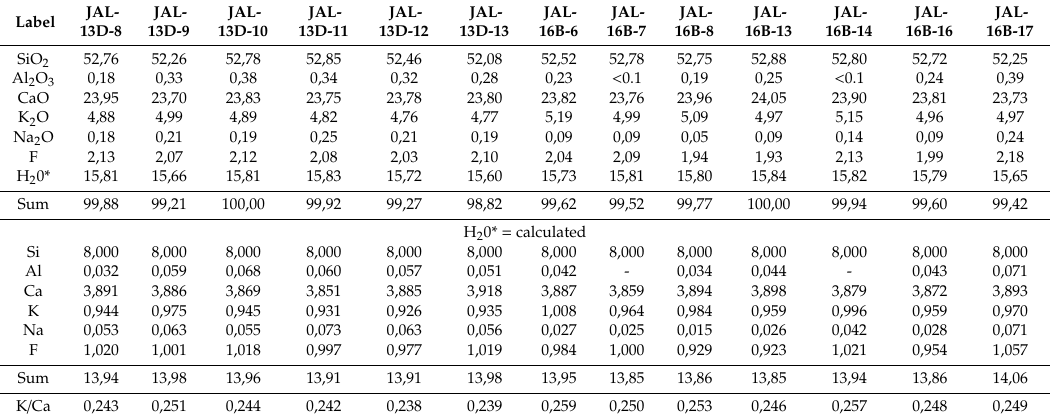
Table 8. Chemical composition (SEM-EDX analyses in wt. %) of apophyllite from samples JAL-13D and JAL-16B. Formula is calculated on the basis Si = 8. Theoretical H 2 O content was calculated based on stoichiometry of the formula with 8 H 2 O. The F-bearing position is completely filled by F for most analysis, only some contain minor amounts of OH, which was